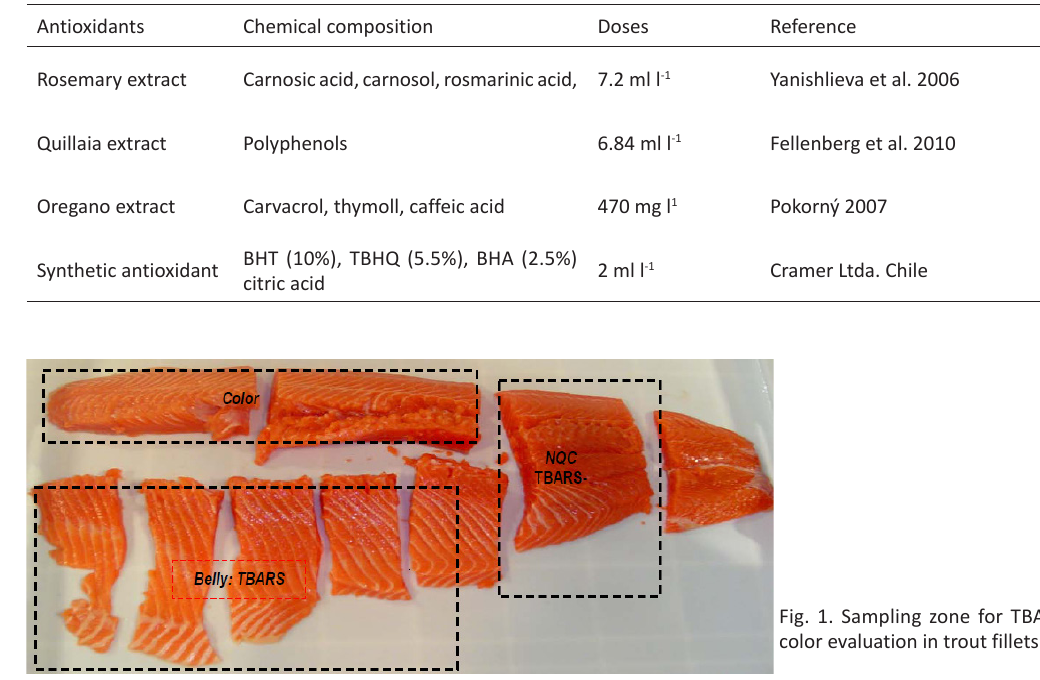
Table 1. Antioxidant treatments and dosage used in the experiments